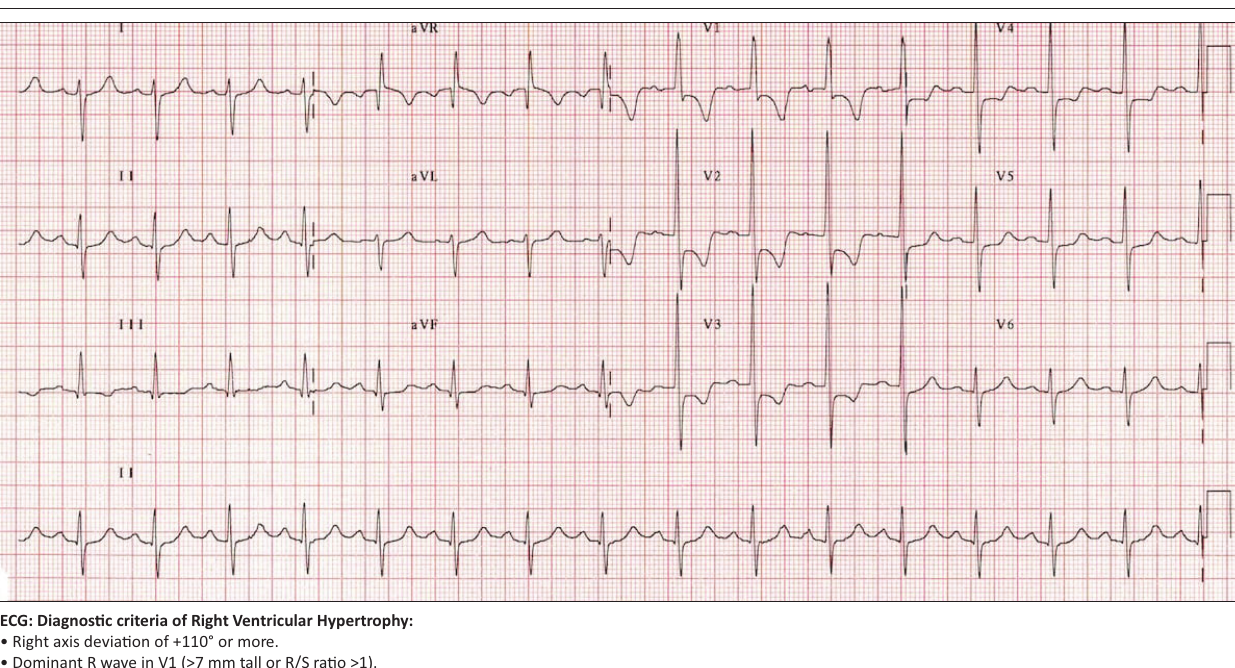
FIGURE 2: Electrocardiogram for objectively structured clinical examination